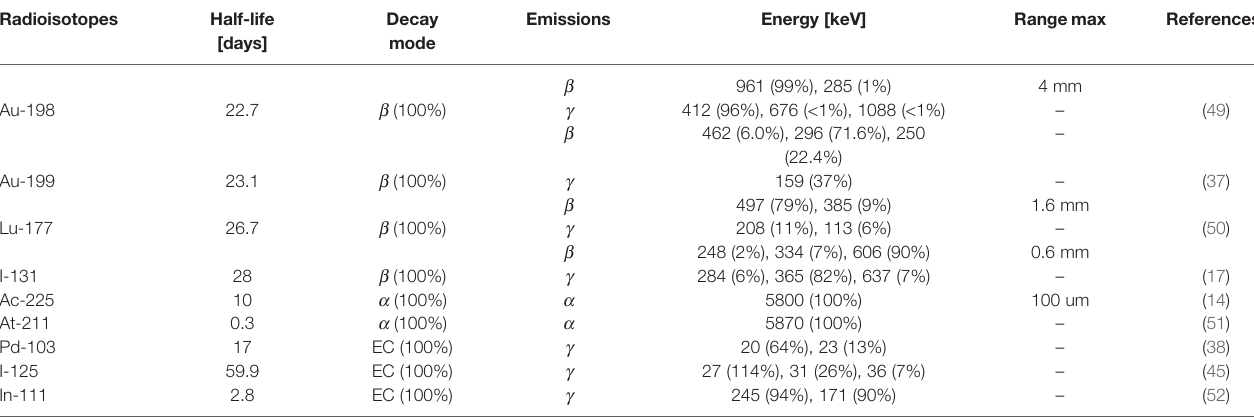
TABLE 1 | Summary of radionuclides and radioactive nanocarriers investigated in preclinical studies on nanobrachytherapy. Radioisotopes Half-life